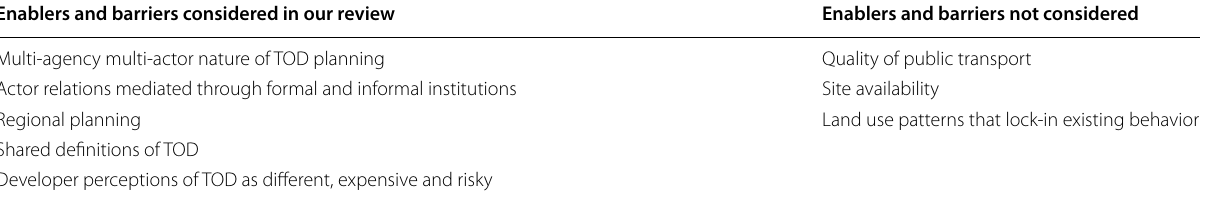
Table 1 Enablers and barriers considered Enablers and barriers considered in our